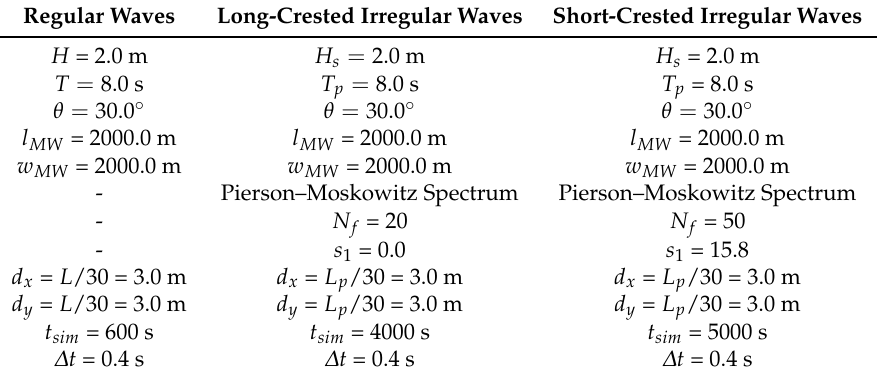
Table 1. MILDwave simulation parameters for the MILDwave-NEMOH coupled model. Regular